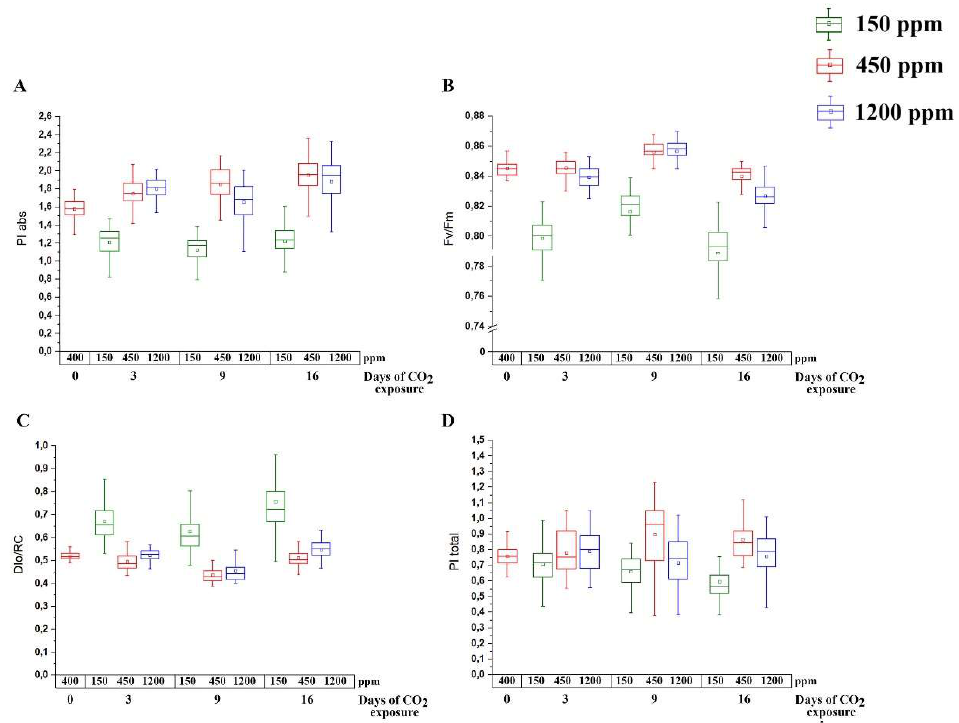
Figure 1. Effect of CO 2 content in the air on photosynthetic parameters of Arabidopsis plants before (0), 3, 9, and 16 days after introduction to low (150 ppm), normal (450 ppm), and high (1200 ppm) CO 2 levels in the air. Red boxes are control plants; green boxes are plants under low CO 2 conditions; blue boxes are plants under high CO 2 conditions. ( A ) PI abs , Photosynthetic performance index, which is estimated to absorption energy per photochemically active reaction center of PSII; ( B ) Fv/Fm, maximum quantum yield of PSII; ( C ) DI 0 /RC, dissipation of light energy per active reaction center; ( D ) PI total performance index. Values are presented from three independent populations. The parameters of 30 leaves were measured in each population.